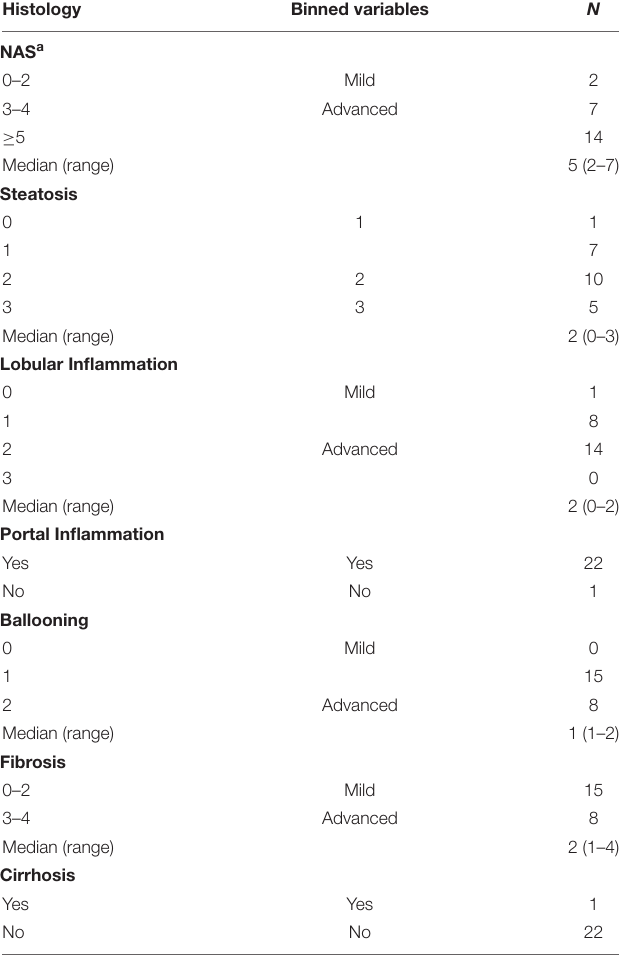
TABLE 2 | Histology of a subset ( N = 23) of subjects with NAFLD on liver biopsy. Histology Binned